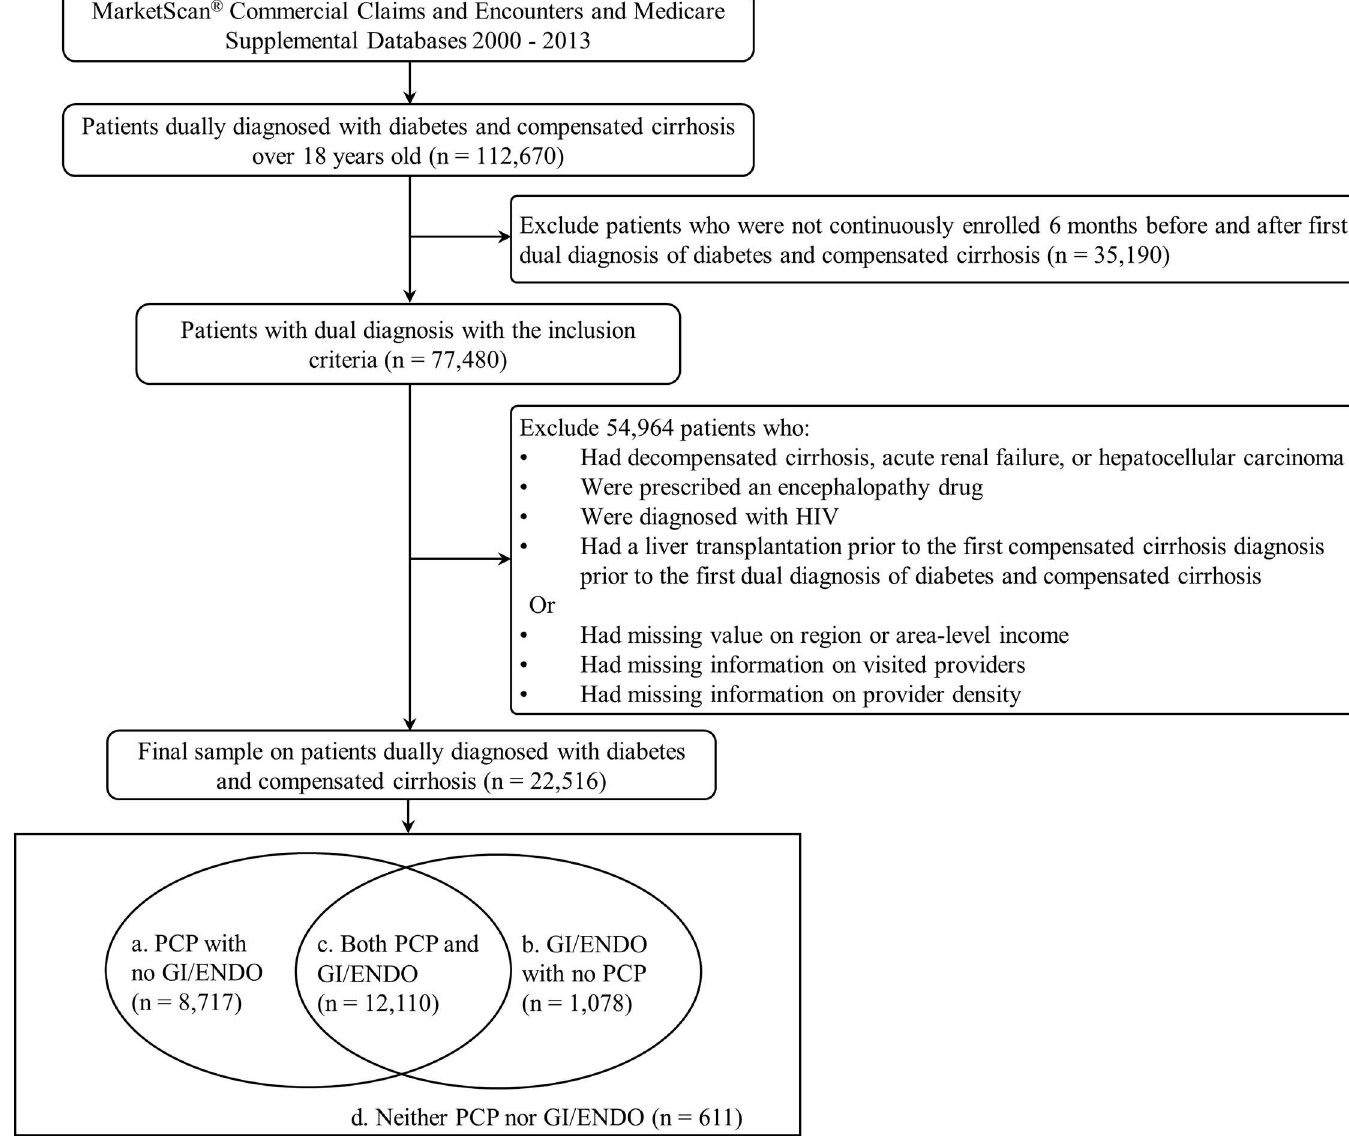
Fig 1. Patient flow for selecting dually diagnosed